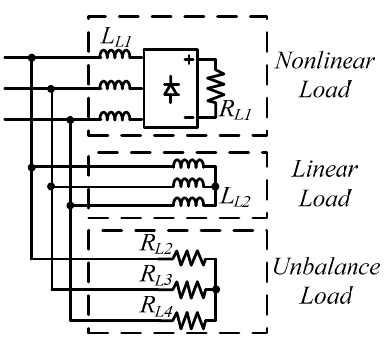
Figure 11. Load condition in simulated scenario.